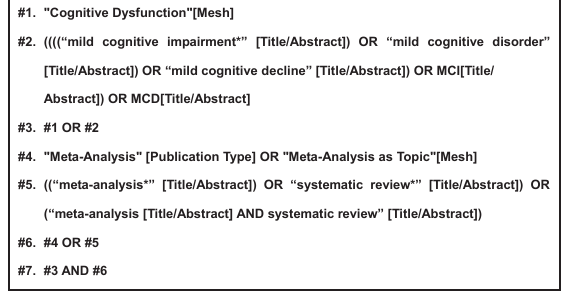
Figure 1. Complete PubMed search